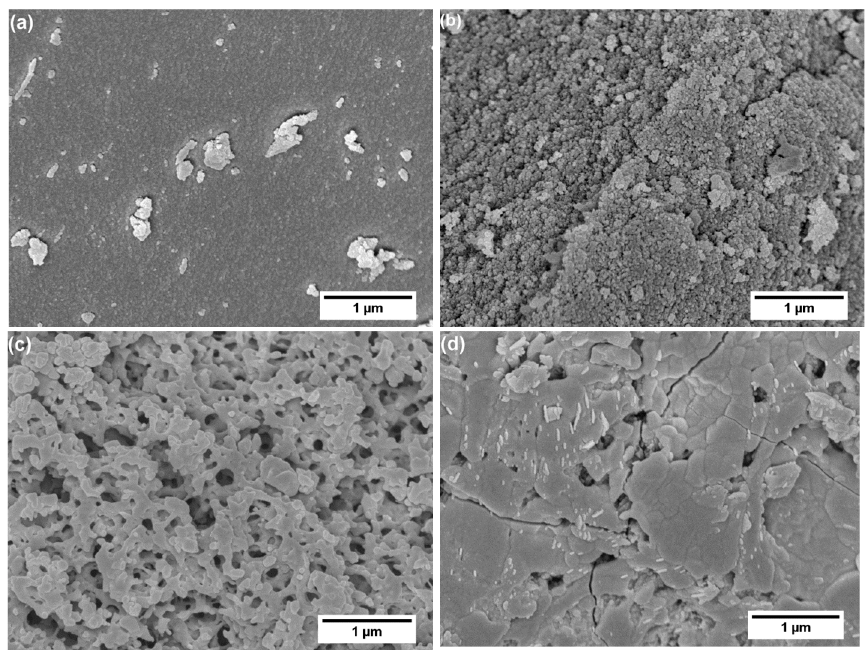
Figure 7. SEM surface morphology analysis of ( a ) SiCa0, ( b ) SiCa5, ( c ) SiCa12, and ( d ) SiCa50.